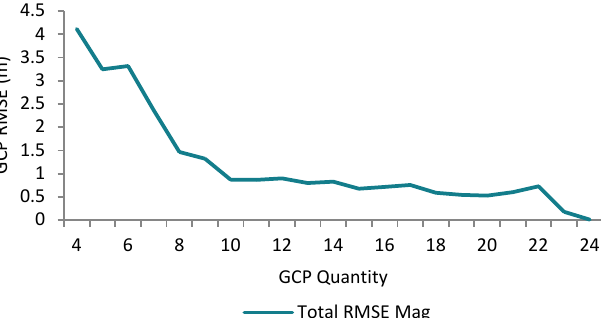
Figure10. Total GCP RMSE magnitude plotted with respect to the GCP Quantity